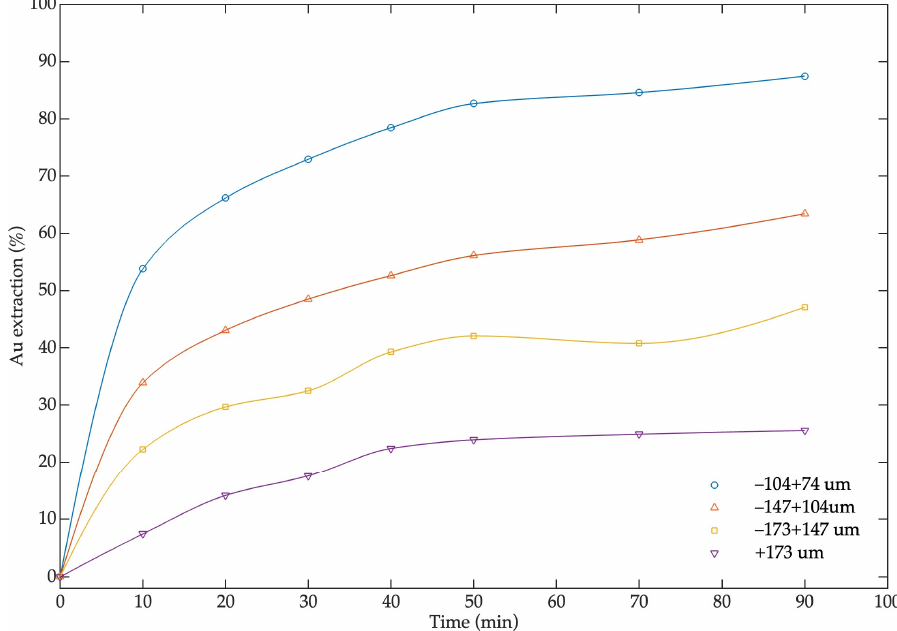
Figure 7. Effect of particle size (micron, μm ) on Au extraction at 6 g/L cyanide concentration, 0.5 MPa pressure, and 40 °C.